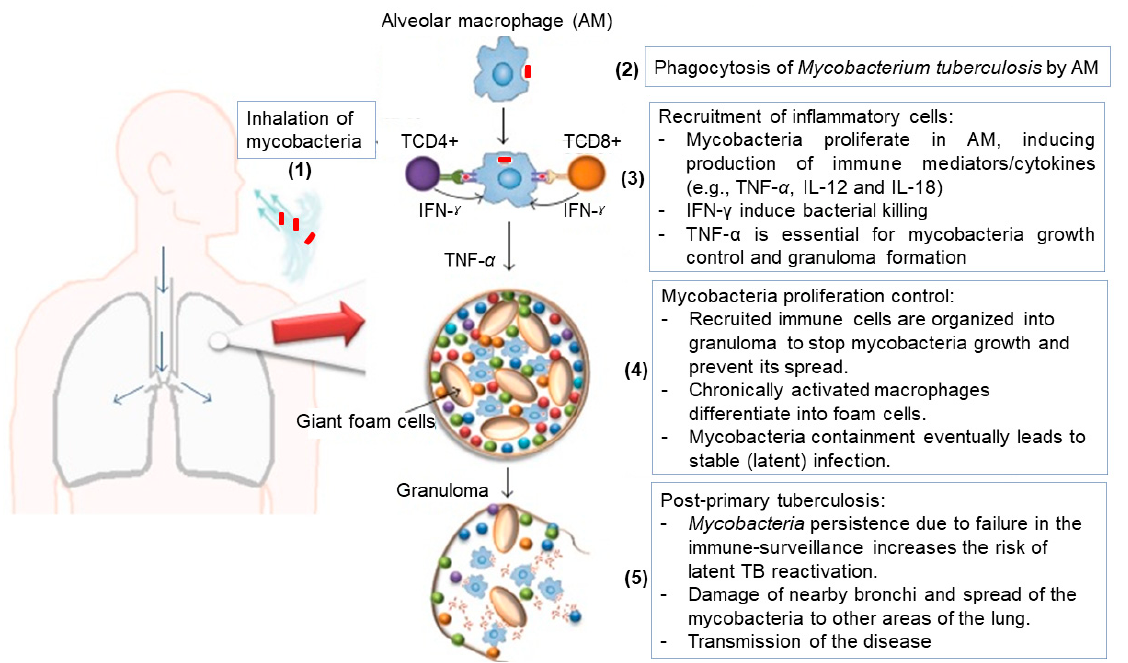
Figure 1. Illustrative description of TB pathogenesis in five consecutive steps: ( 1 ) mycobacteria entry, ( 2 ) interactions with alveolar macrophages, ( 3 ) recruitment and stimulation of immune cells, ( 4 ) mycobacteria containment in granuloma, ( 5 ) active TB disease. Adapted from [26].